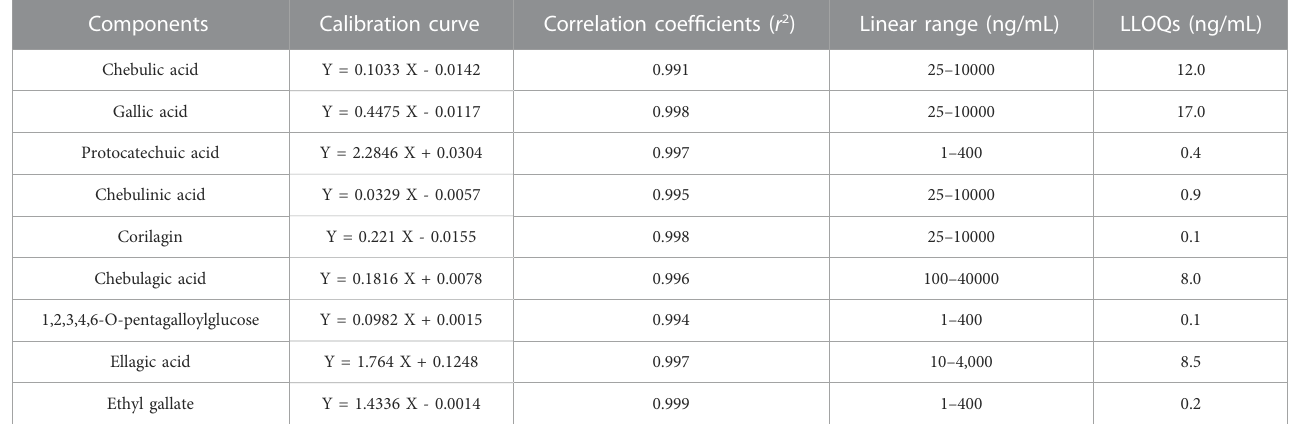
TABLE 3 Calibration pro fi les, correlation coef fi cients, linear ranges and LLOQs of the nine analytes. Components Calibration curve Correlation coef fi cients ( r 2